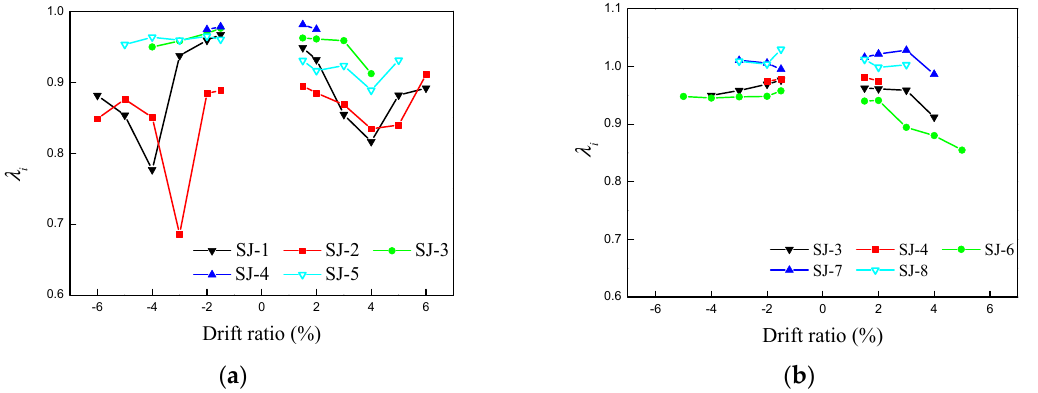
Figure 18. Strength degradation coefficients at the same drift level. ( a ) Specimens SJ-1 through SJ-5; ( b ) Specimens SJ-3, SJ-4, SJ-6 through SJ-8.